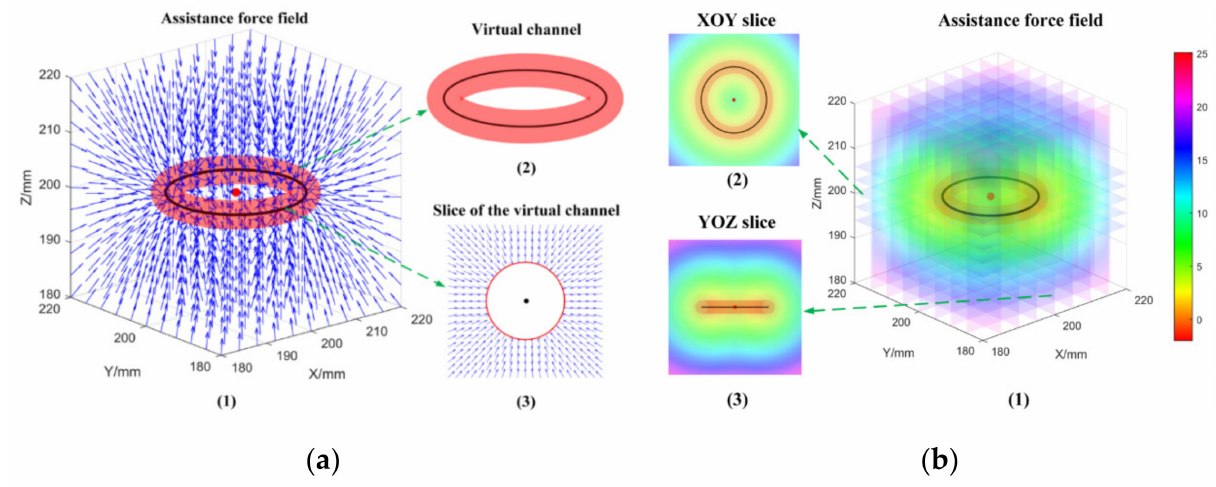
Figure 7. The schematic diagram of the assistance force field with the FTR (take a circular trajectory as an example). ( a ) is the schematic diagram of the assistance force field; ( b ) is the distribution of the assistance force